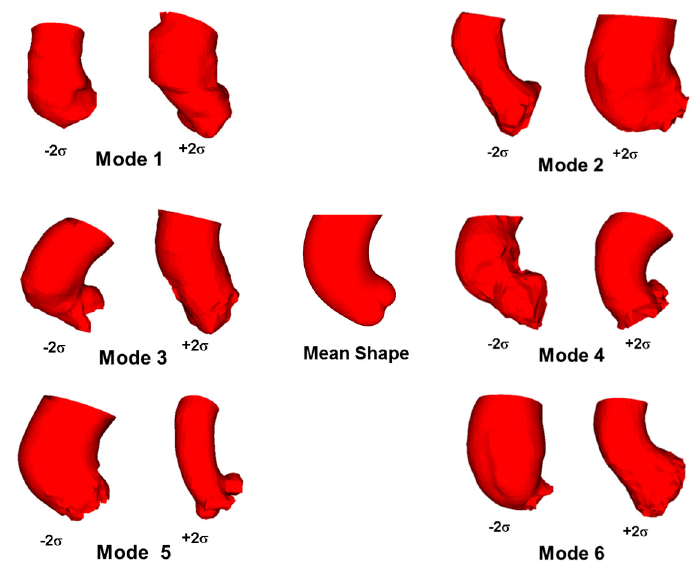
Figure 3. Dominant shape modes shown by deformations of the computed template from low ( − 2 SD) to high ( + 2 SD) values for BAV & TAV ATAA together.